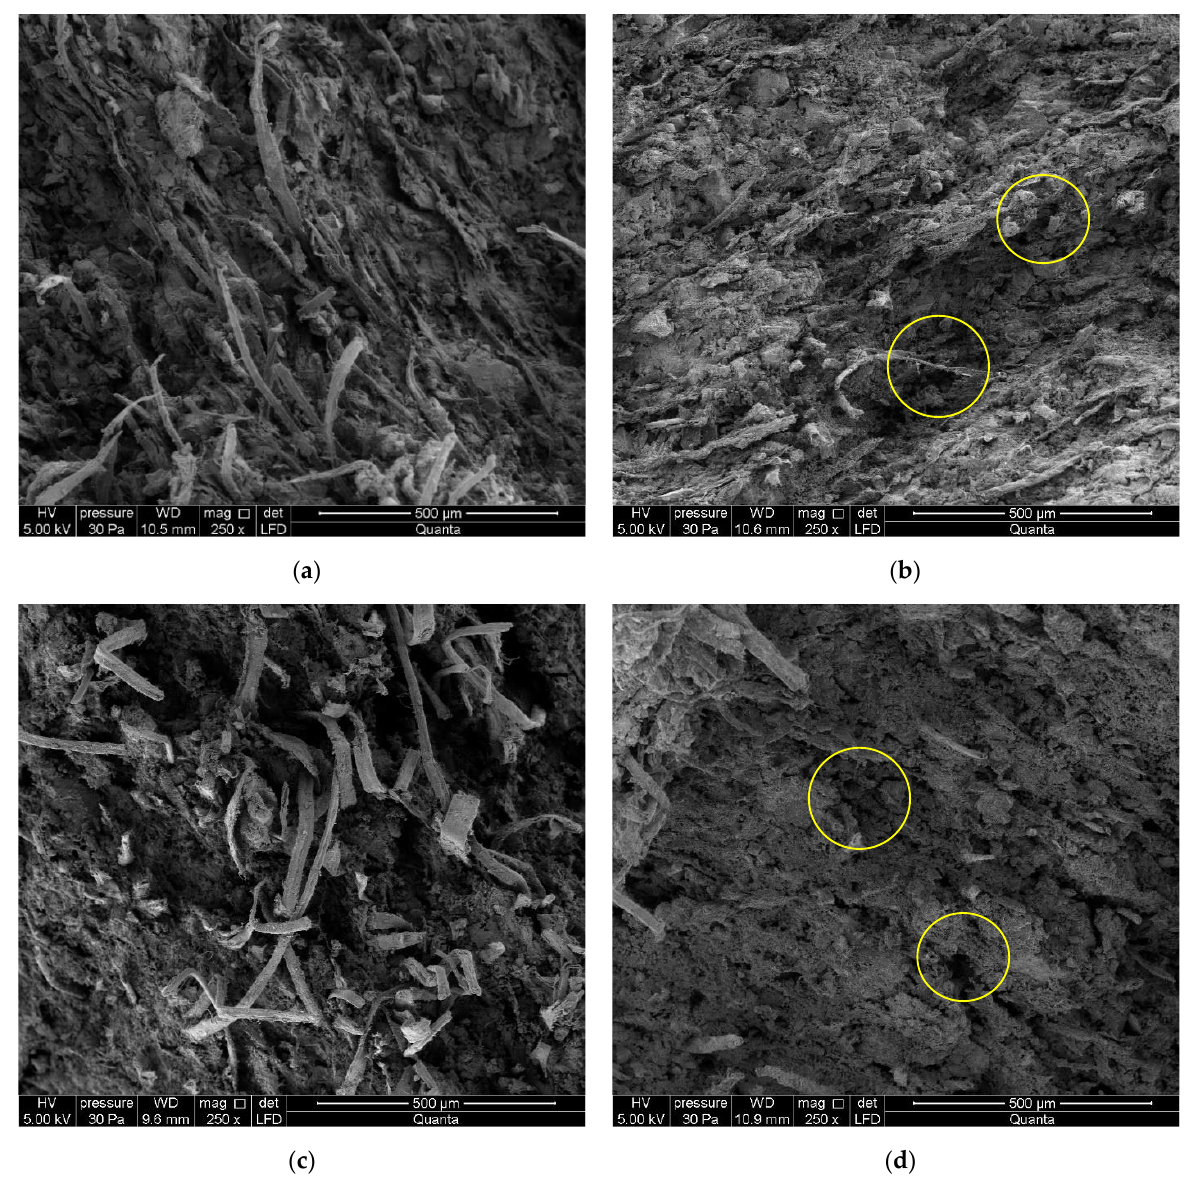
Figure 10. SEM images of boards of series: ( a ) A R , ( b ) A T , ( c ) C R , ( d ) C T .